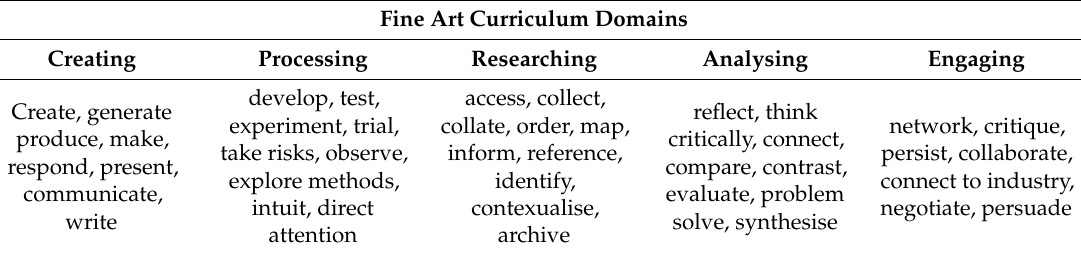
Table 1. Fine Art Curriculum